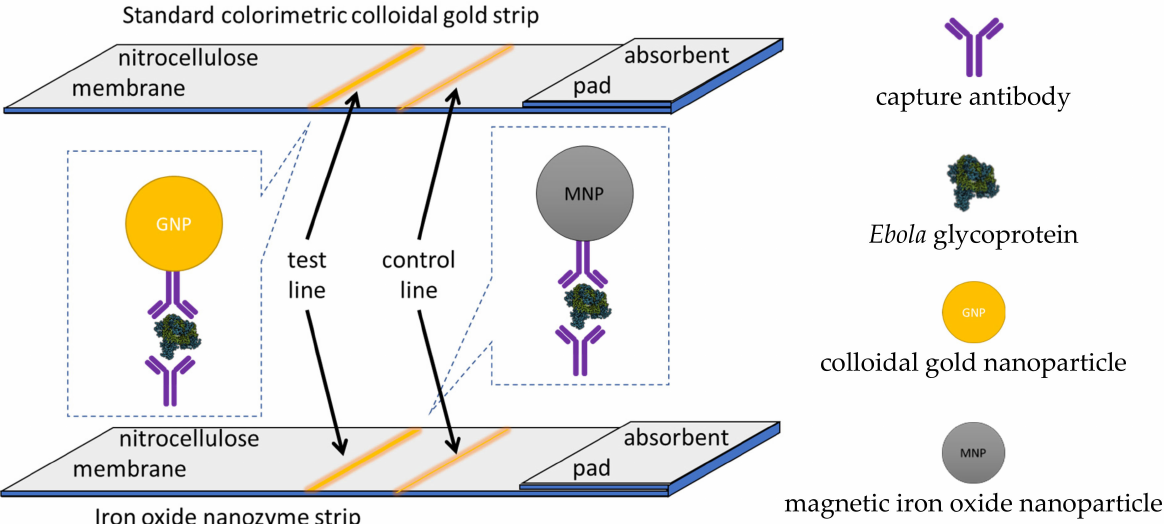
Figure 13. The iron oxide colorimetric immunoassay nanozyme strip developed for the indirect detection of Ebola and the standard strip made of colloidal gold